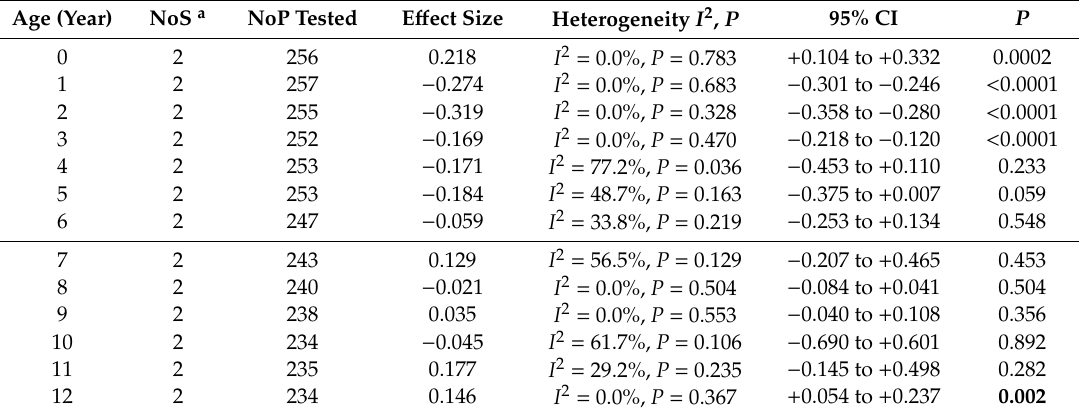
Table 8. Meta-analyses of weight-for-age z-scores in children with mild